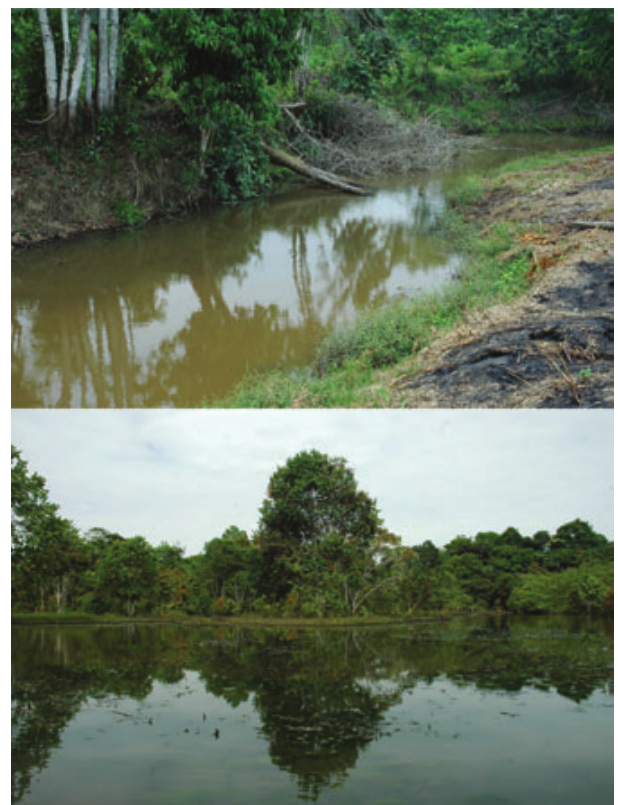
Fig. 4. Habitat of Thalassophryne amazonica in two localities of the Peruvian Amazon where the species was collected. a